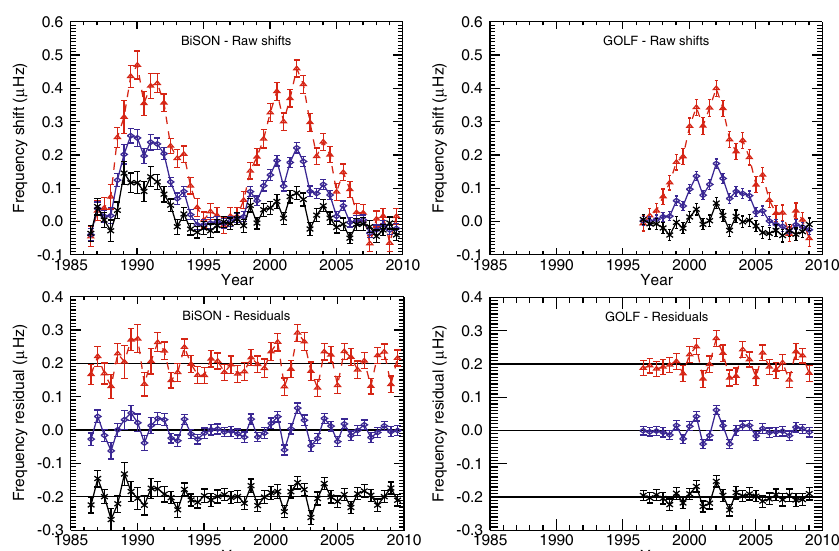
Fig. 29 The upper panels show the shifts in frequencies of low-degree modes from BiSON ( left ) and GOLF ( right ) as a function of time. The blue solid line is for all modes with frequencies between 1.88 and 3.71 mHz. The black and red lines are subsets: black for 1.88 to 2.77 mHz and red from 2.78 to 3.71 mHz. The lower panels show the residuals when the dominant solar-cycle trend is removed. The black and red curves have been displaced by 0 . 2 and − 0 . 2mHz respectively for the sake of clarity. (Image reproduced with permission from Fletcher et al. 2010, copyright by